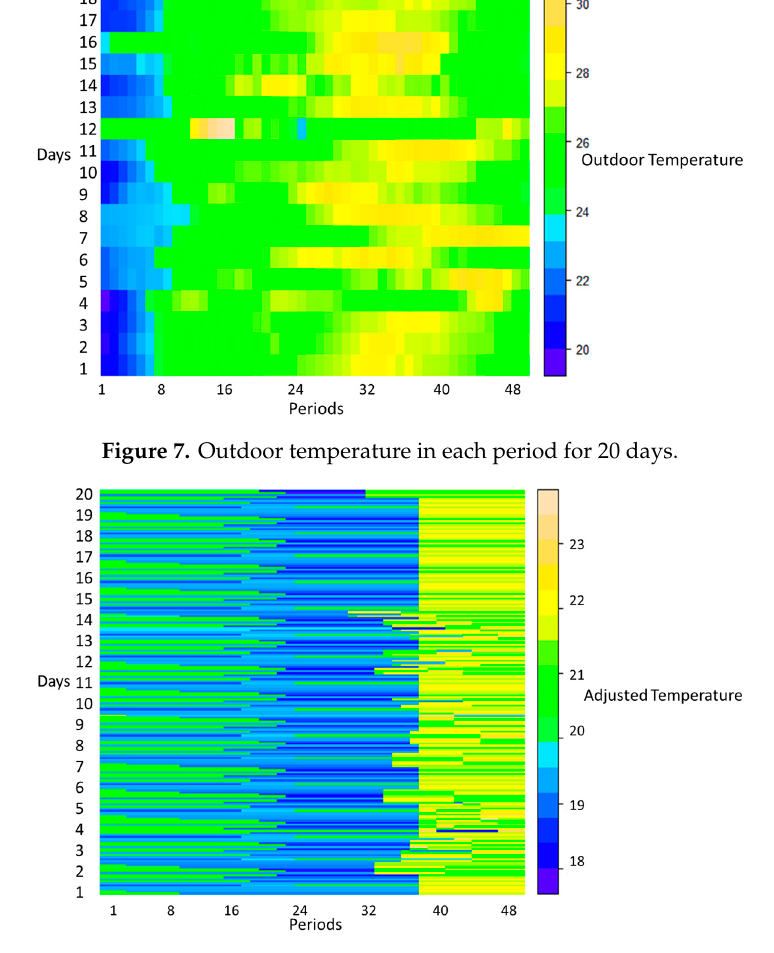
Figure 9. Coefficients regarding maximum allowed power reduction of lights and ACs. ( A ): amount of Max_L_h; ( B ): amount of Max_AC_h.